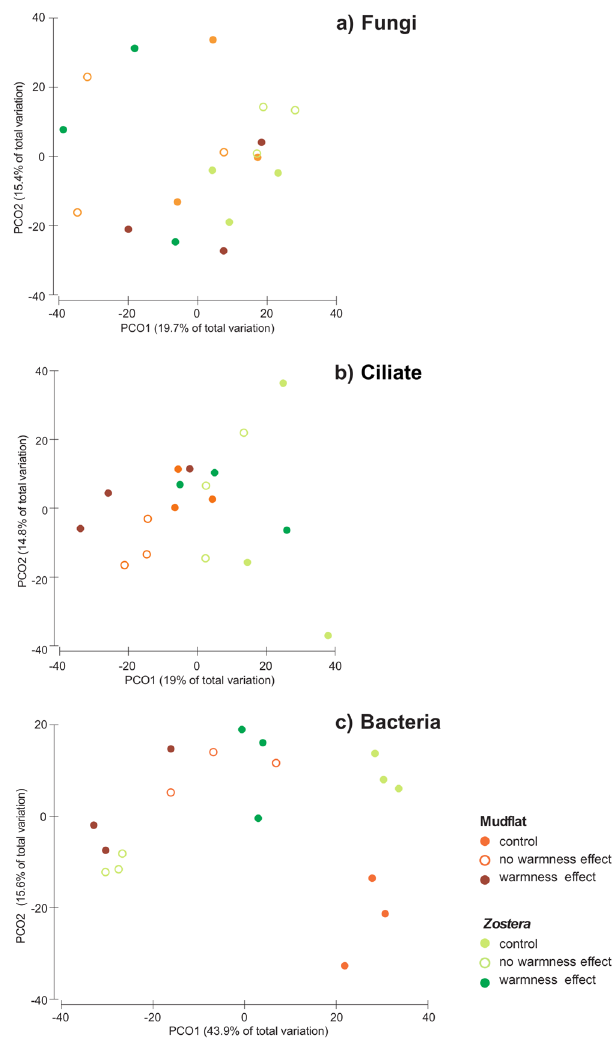
Figure 4. PCO ordination for fungal ( a ), ciliates ( b ) and bacterial ( c ) communities for each site and temperature treatment.